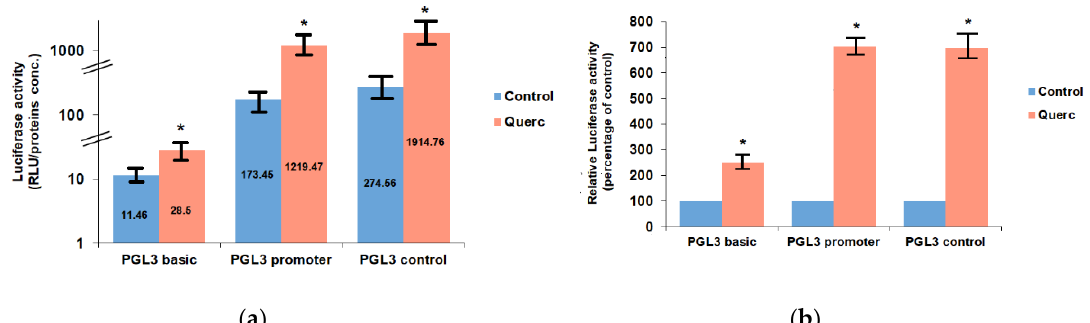
Figure 1. E ff ects of 10 µ M quercetin on Luciferase activity in Fischer Rat Thyroid cell Line FRTL-5 cells transiently transfected with PGL3 basic, PGL3 promoter and PGL3 control. ( a ) Data are expressed as Relative Lights Units (RLU) to protein concentrations (proteins conc.) ratio and represent the means ± S.D. of three separate experiments; ( b ) Same data expressed relative to the control of each vector (set to 100%). Control, cells treated with the control vehicle (0.1% ethanol); Querc, cells treated with 10 µ M quercetin. * p < 0.05 versus relevant control.